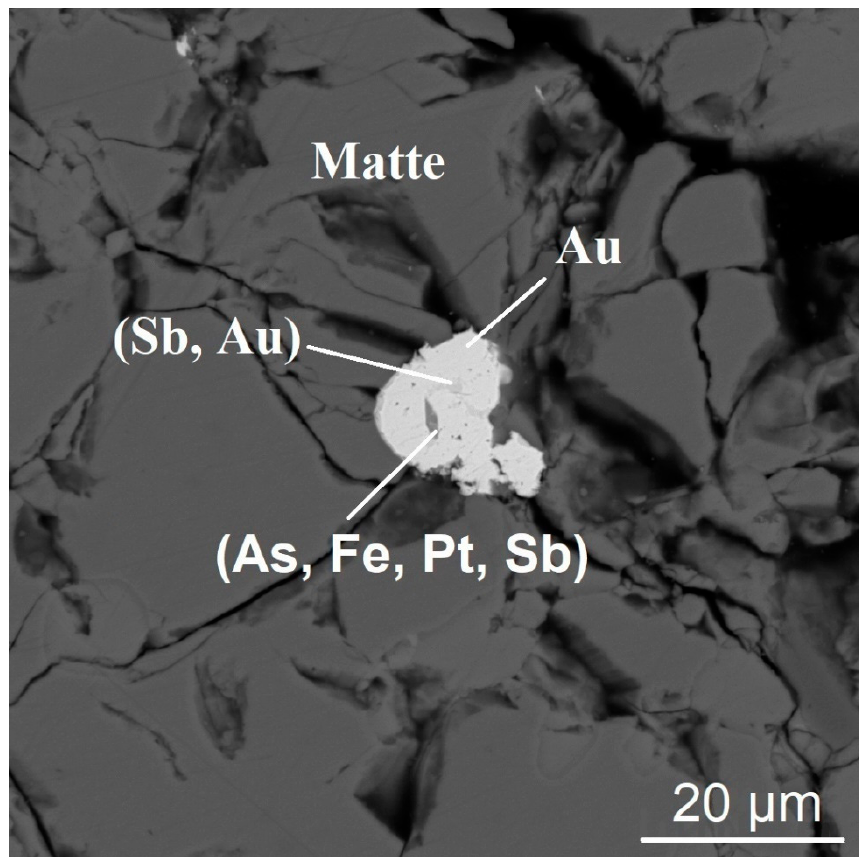
Figure 1. Gold-containing particle in matte after melting of gold-bearing pyrite ore at a temperature of 1300 °C.